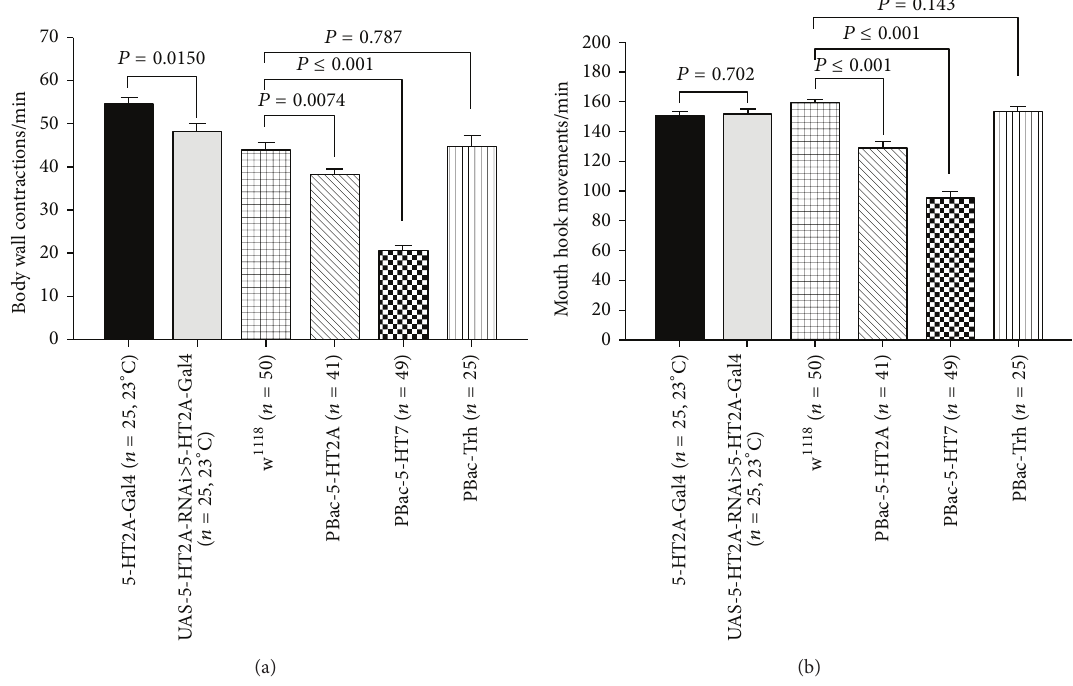
between w 1118 and 5-HT2B mutant (line 2) larvae